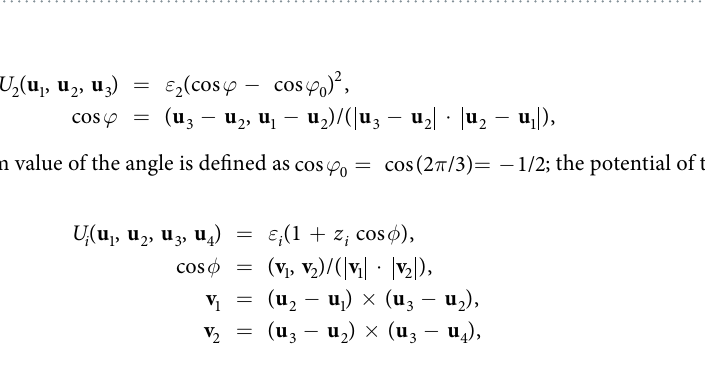
Figure 15. Configurations containing up to i th type of nearest-neighbor interactions for ( a ) i = 1, ( b ) i = 2, ( c ) i = 3, ( d ) i = 4, and ( e ) i =